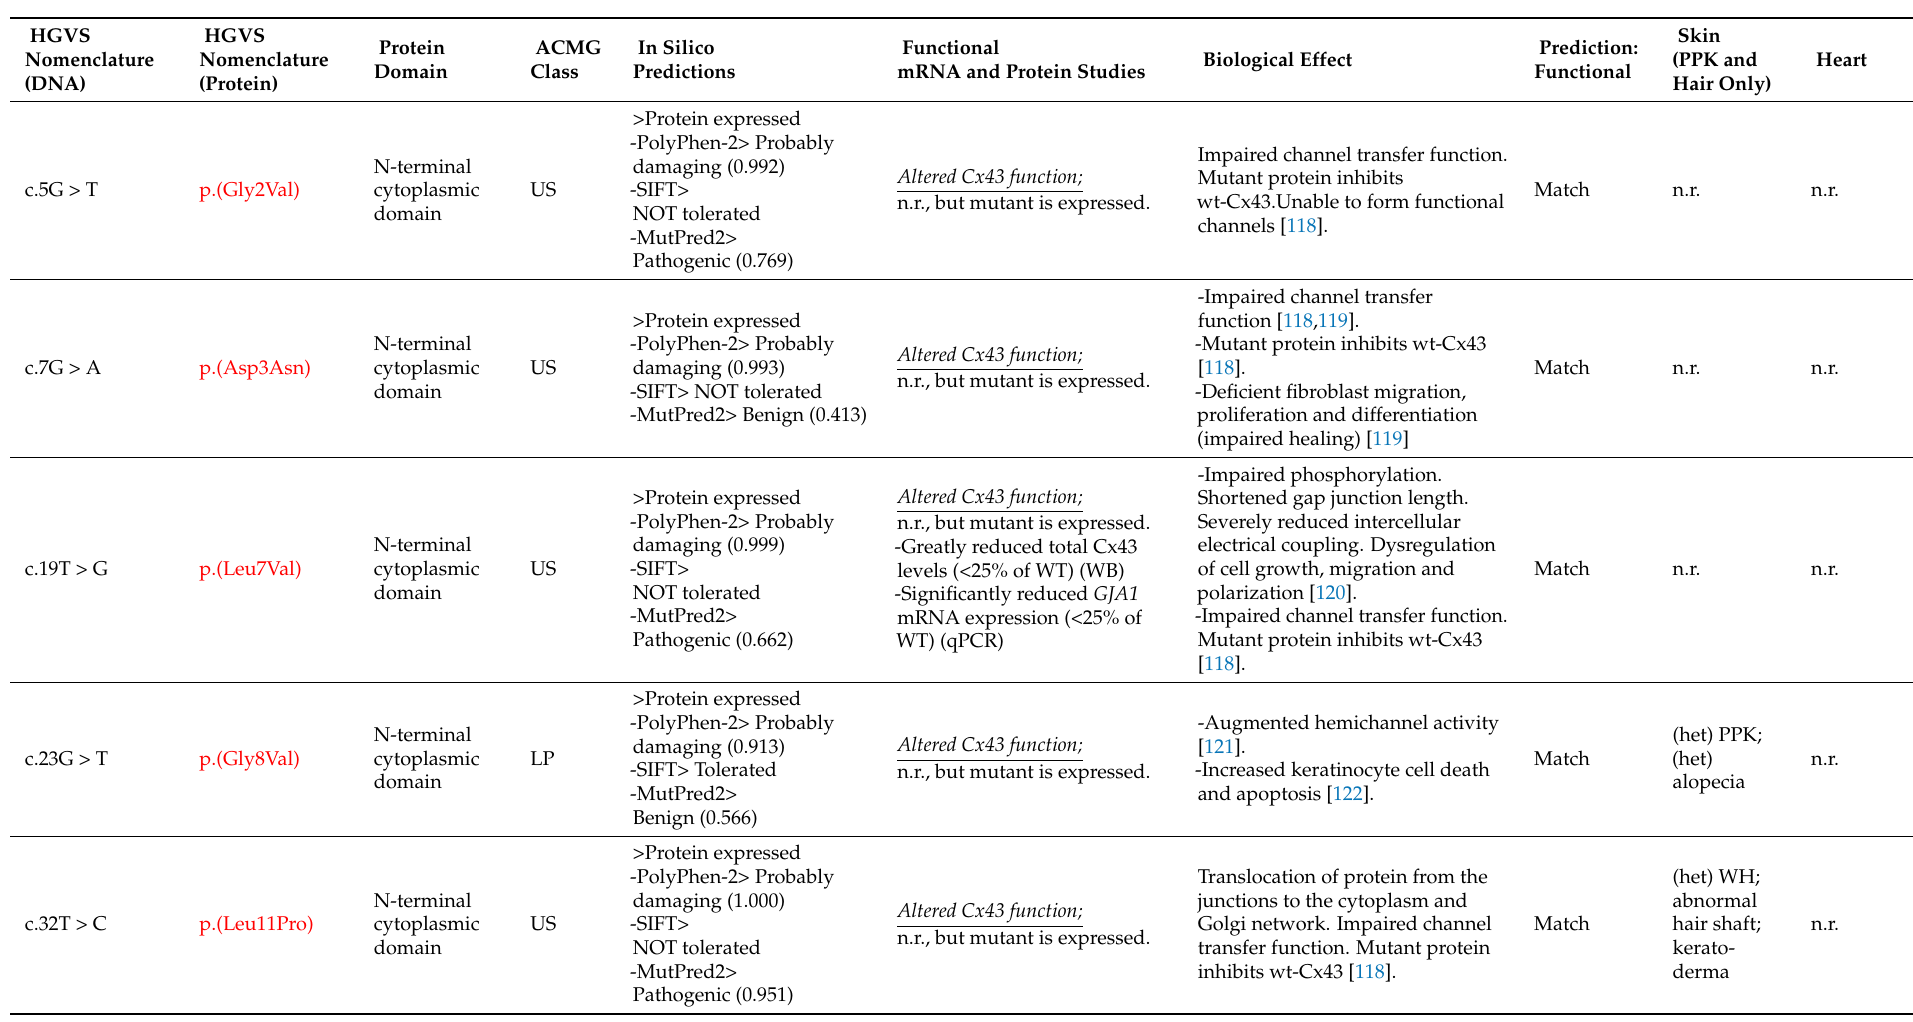
Table 5. Functionally analysed GJA1